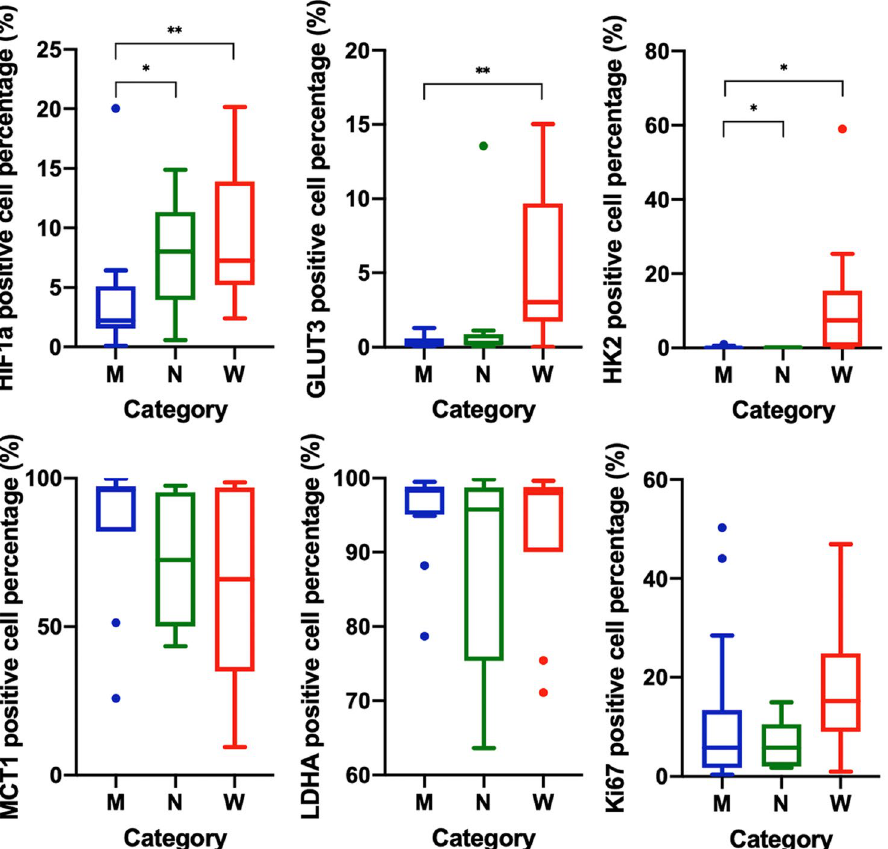
Figure 4. Box-whisker plots of histological measurements, namely, HIF1a-, GLUT3-, HK2-, MCT1-, LDHA-, and Ki67-positive cell percentages. The box shows the interquartile range between the 25th and 75th percentiles for positive cell percentage; the lines within boxes represent medians, and the whiskers represent measurements 1.5 times the interquartile range. The circles represent outliers beyond 1.5 times the interquartile range.